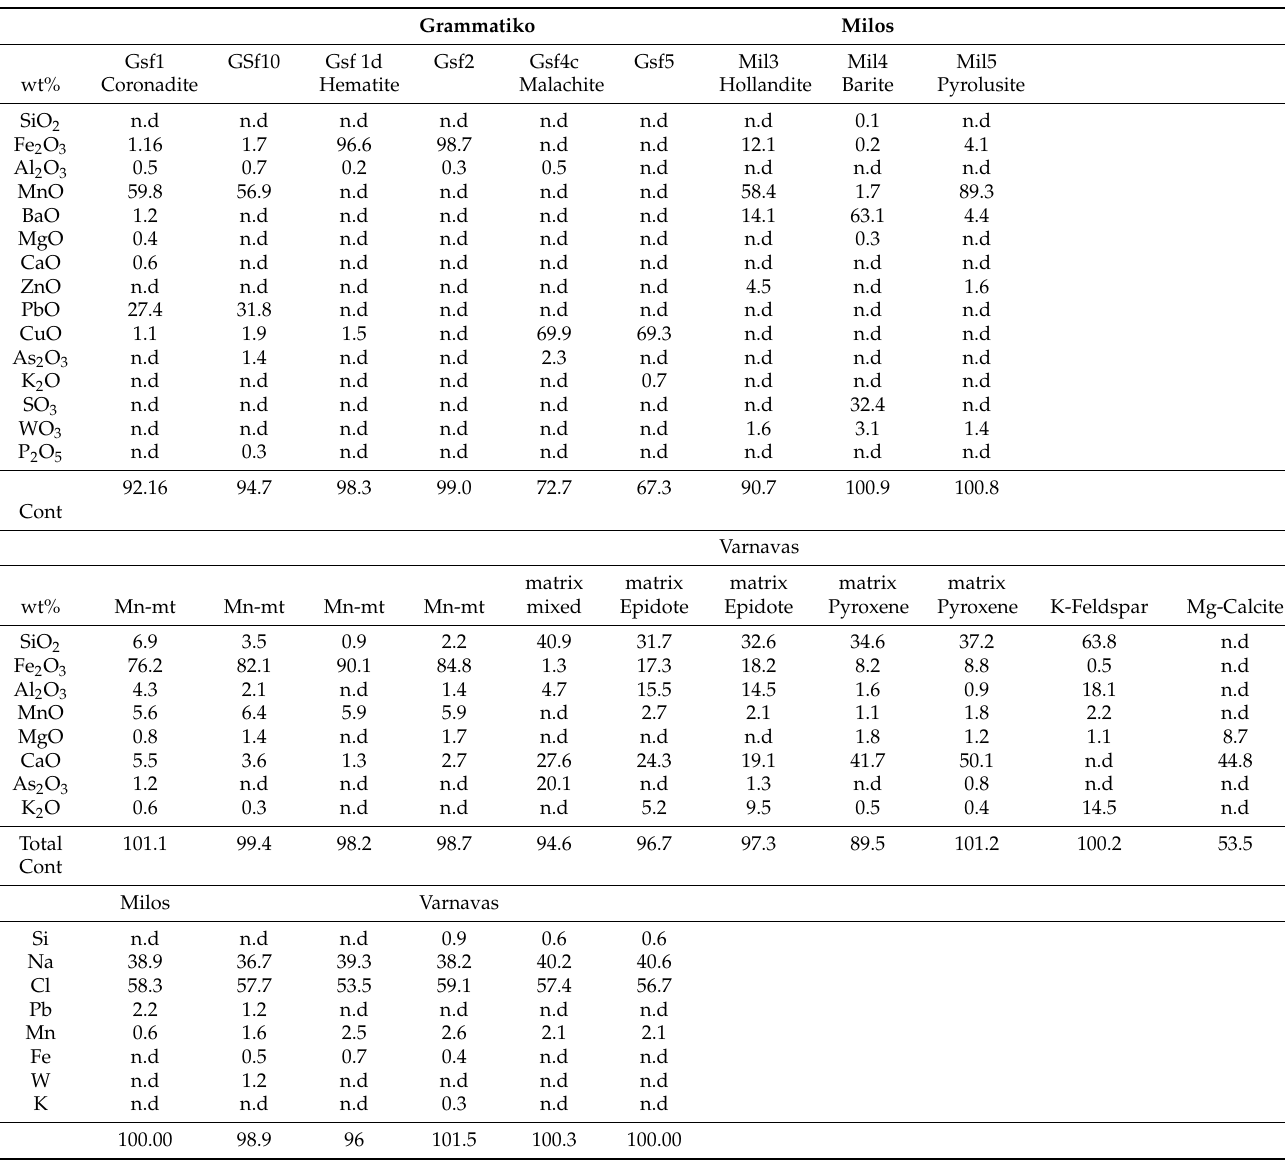
Table 1. Representative SEM-EDS analyses from Fe-Mn mineralization in Attica and Milos